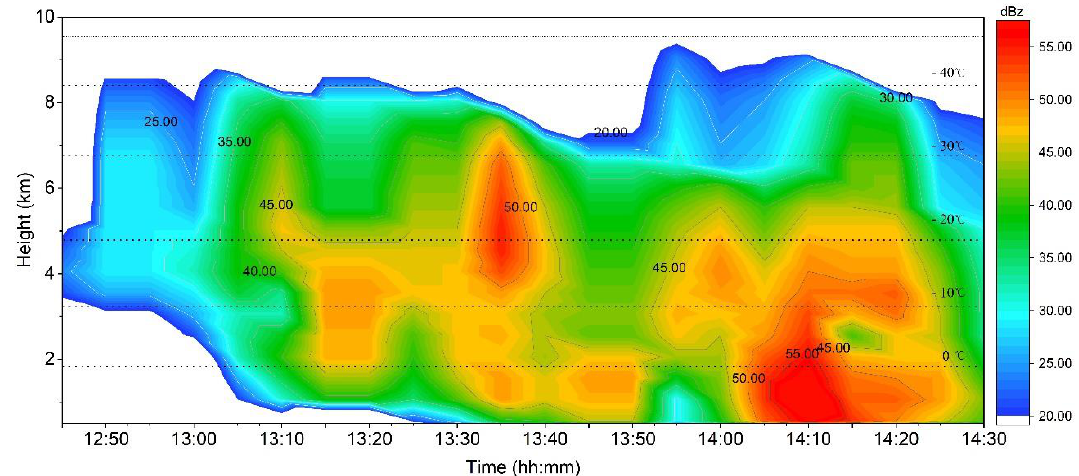
Figure 4. Evolution of the strong echo center of Cell III through its life cycle (the strongest echo column is assembled from Cell III every five minutes).